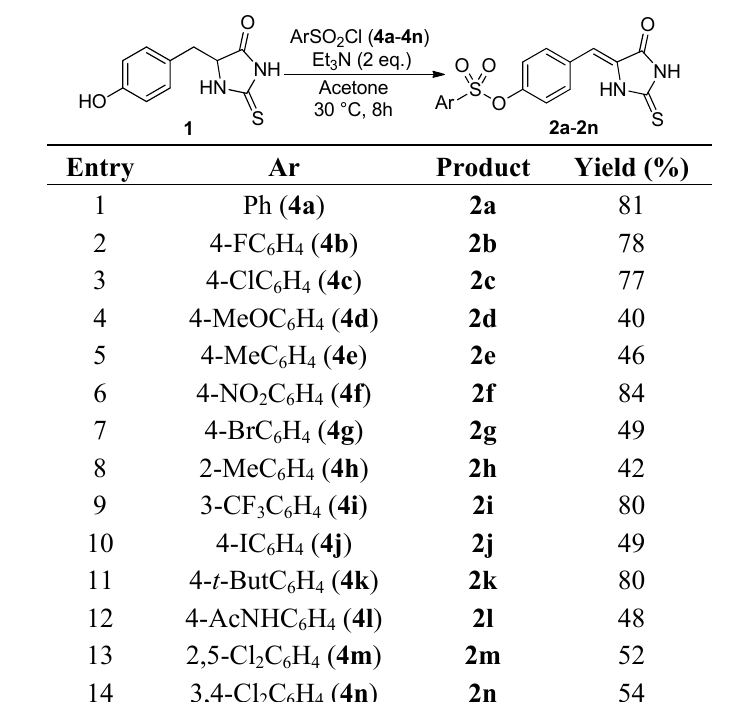
Table 2. The reaction of 1 and arylsulfonyl chloride ( 4